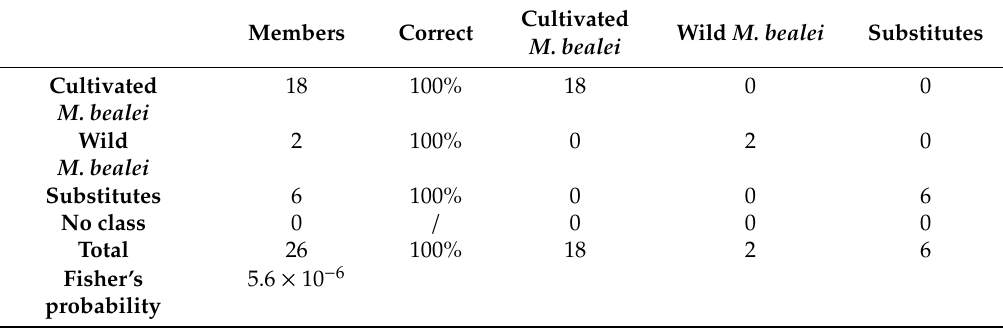
Table 2. Prediction results for 26 batches of